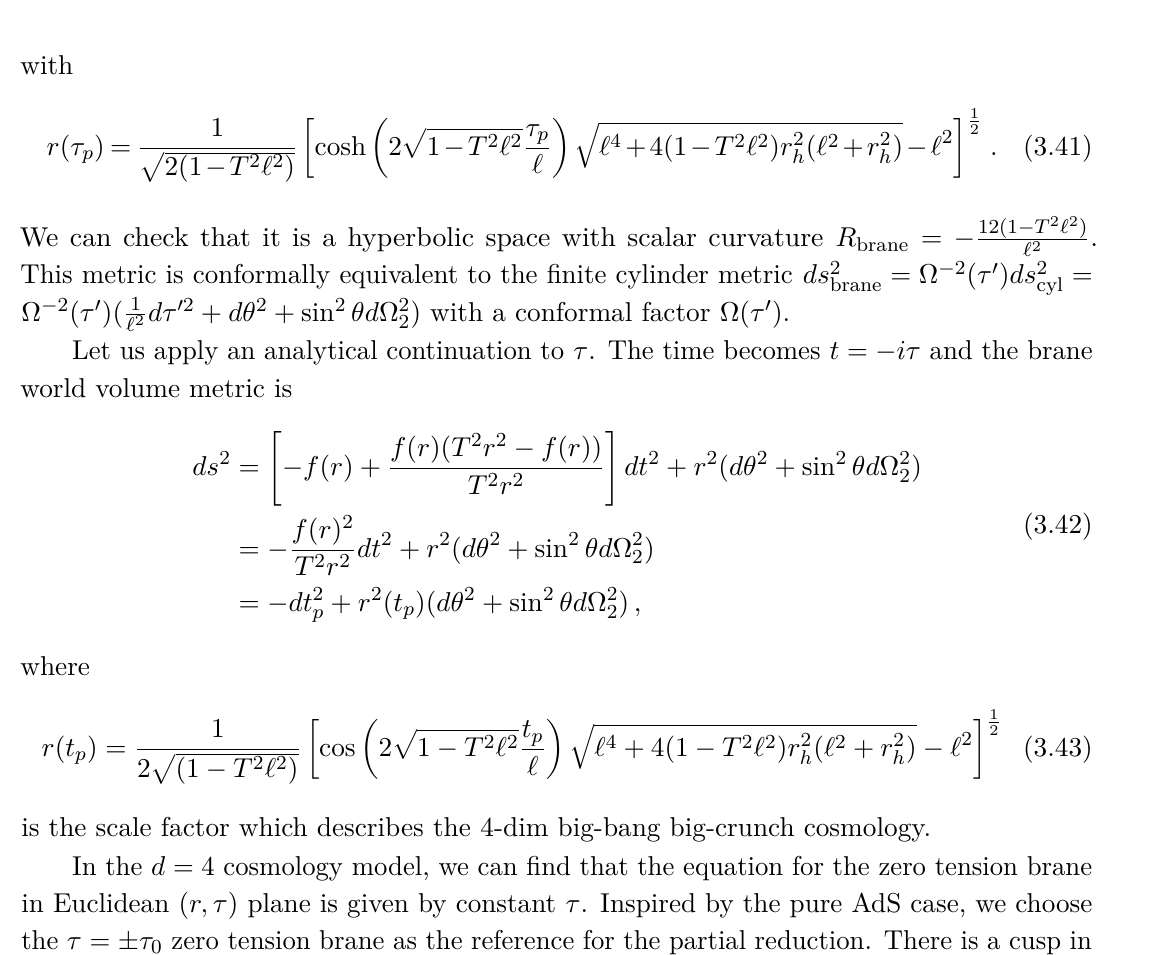
Figure 14 . Partial reduction procedure for d = 4 cosmology. The red solid line is a finite tension brane. The red dash line is the antipodal zero tension brane and the cusp zero tension brane. The orange region is dual to the boundary and the green region is reduced to the EOW